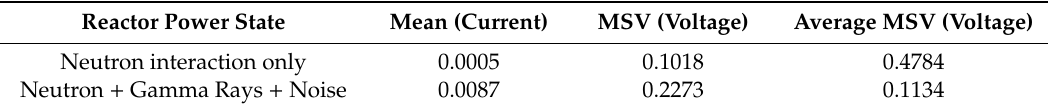
Figure 7. Current with respect to neutron interactions. Table 3. Mean (Current), MSV (Voltage) and Average MSV (Voltage) RMSE.